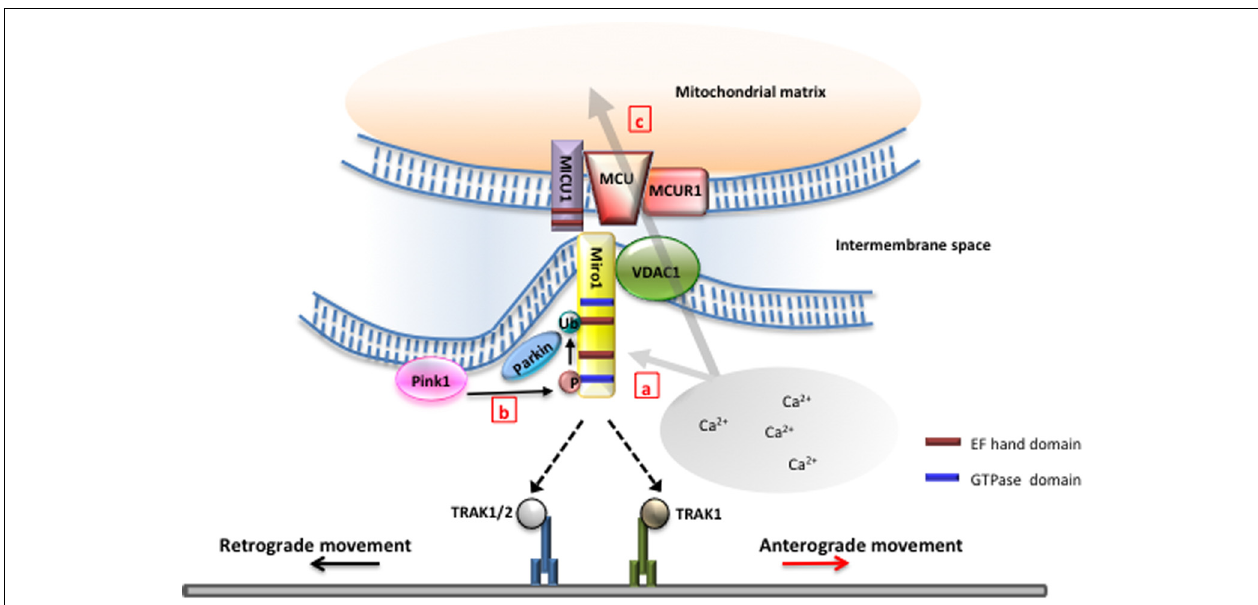
of miro by parkin have been found to play a critical role in the initial stages of mitophagy (Wang etal., 2011). (c) Miro has been found to play a role upstream of the mitochondrial calcium uniporter complex in controlling Ca 2 + influx into the matrix. Mutations in the EF-hands of miro1 removes this function (Chang etal., 2011). Ca 2 + influx through the mitochondrial calcium uniporter has also been shown to gate mitochondrial movement (Chang etal.,